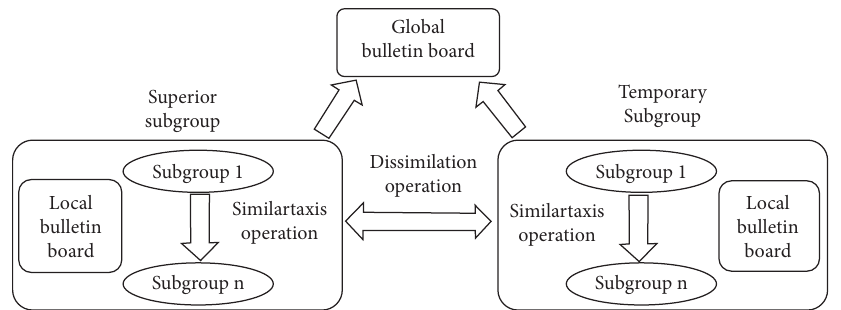
Figure 2: The structure diagram of MEA.